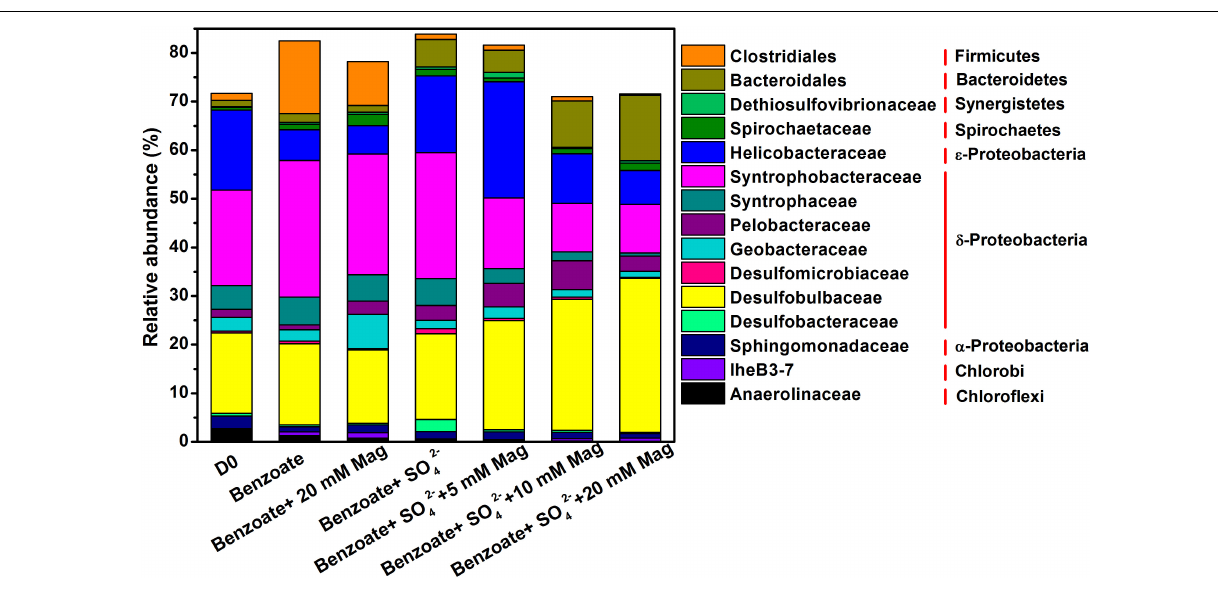
FIGURE 5 | Taxonomic classification of 16S rRNA gene sequences from the extract DNA from anaerobic incubation of sulfate-dependent benzoate degradation in the presence and absence of magnetite, the sulfate-free control incubations and microbial inocula at the family level with a relative abundance greater than 1%. Mag denotes